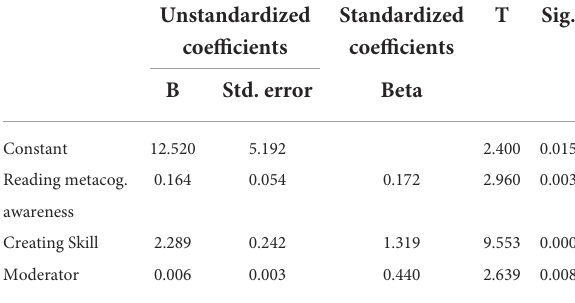
TABLE 12 Effect of reading metacognitive awareness on creating